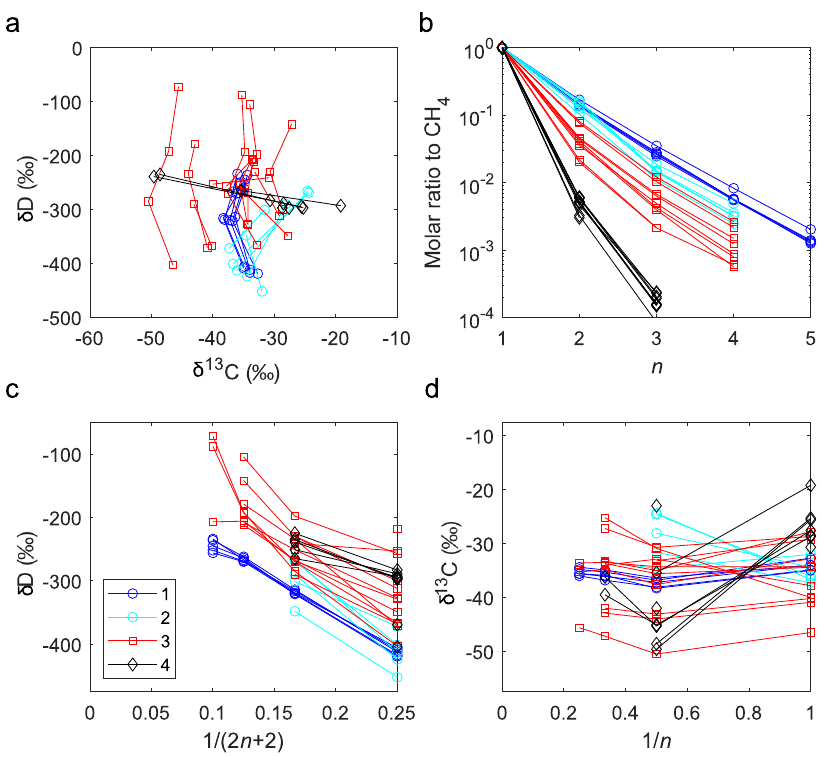
Fig. 4 Comparison of molecular and isotopic compositions between alkanes from pre-GOE and post-GOE sites. a δ 13 C versus δ D of alkanes. b Exponential (Flory – Schulz) distribution of alkane abundance. c δ D versus reciprocal of hydrogen number. d δ 13 C versus reciprocal of carbon number. Pre- GOE sites: 1 — Kidd Creek mines (2.7 Ga); 2 — Copper Cliff mines (2.45 Ga); 3 — Kloof, Driefontein, and Mponeng mines (3.0 – 2.7 Ga). Post-GOE sites: 4 — Juuka and Pori mines (1.95